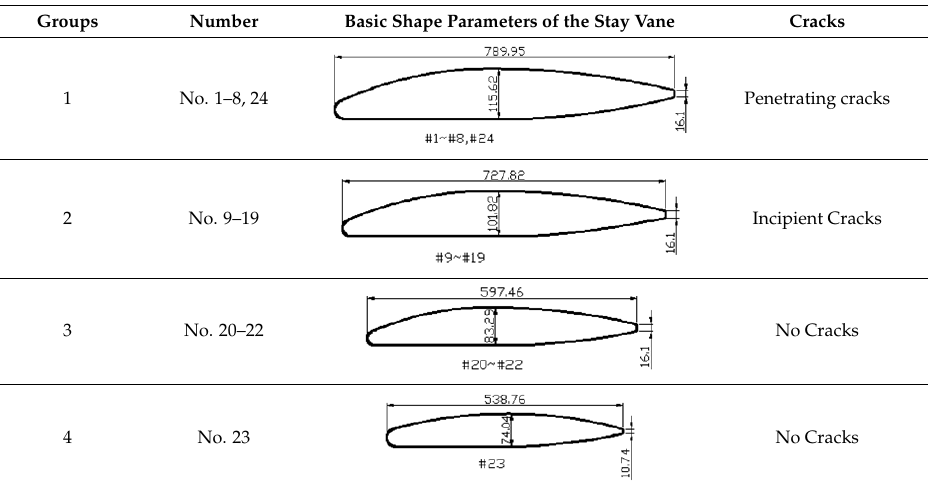
Table 1. Crack detection results of stay vanes.